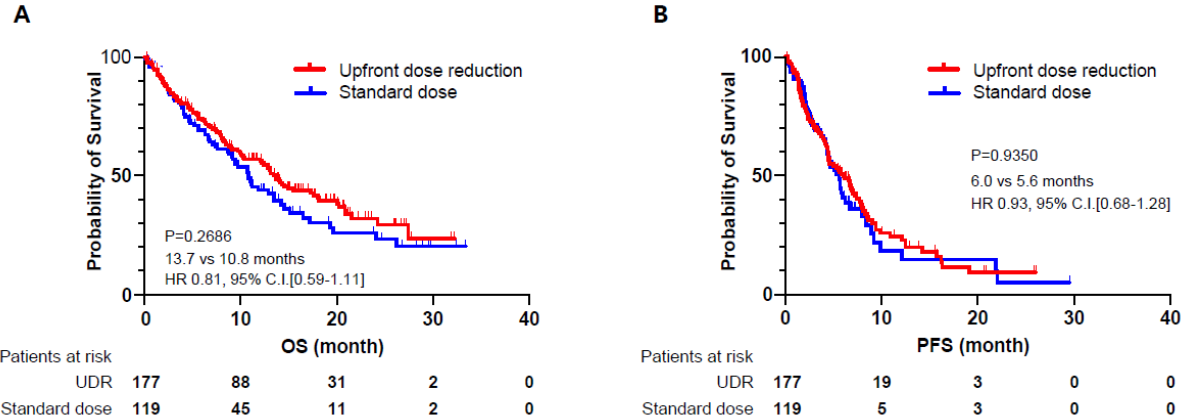
Figure 1. Kaplan-Meier curves for overall survival (OS) and progression free survival (PFS) between the standard dose group and the group with upfront dose reduction (UDR). ( A ) overall survival ( B ) progression free survival. CI, confidence interval; HR, hazard ratio.